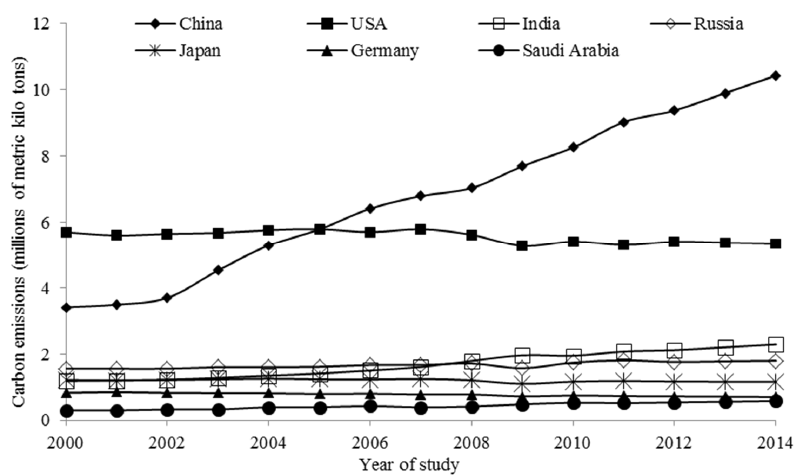
Figure 1. Country wise carbon emissions (metric kilotons) in transportation sector.